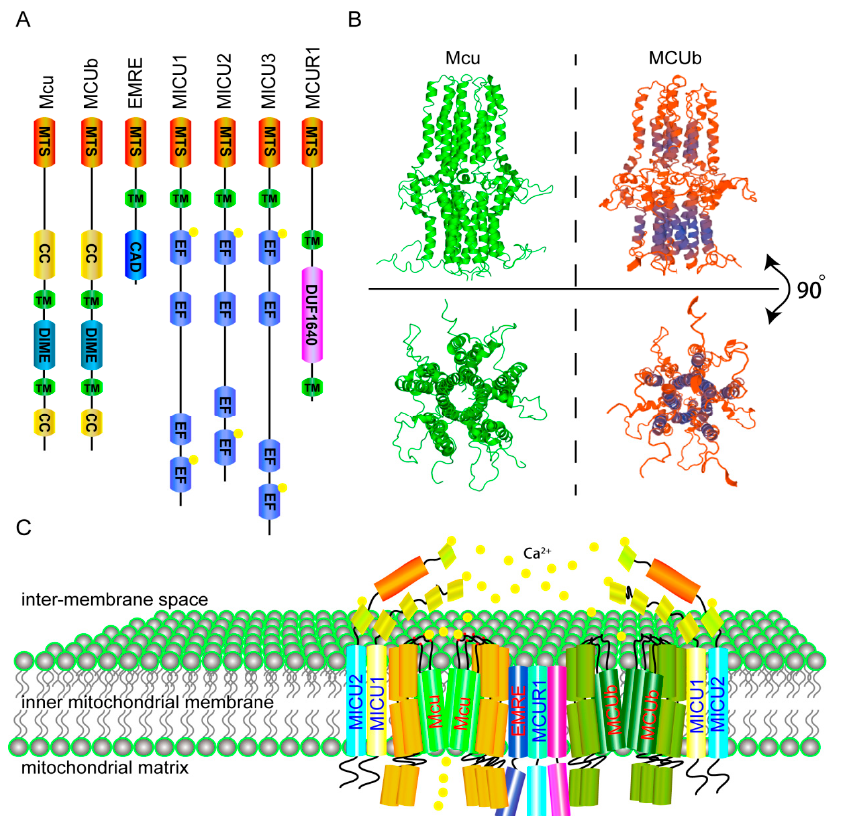
Figure 1. The molecular components and structure of mitochondrial calcium uniporter (MCU). ( A ) The components of Homo sapiens MCU. From left to right, the schematic shows a linear overview of the predicted domain architecture of each of the seven Homo sapiens MCU components. MTS: mitochondrial targeting signal, TM: transmembrane domain, CC: coiled-coil domain, DIME: the conserved DIME motif, CAD: carboxy-terminal domain, EF: EF-hand domain, DUF1640: protein of unknown function (DUF1640); ( B ) The structure of Mcu- ∆ NTD (left) and MCUb- ∆ NTD (right). Upper: front view of Mcu and MCUb show both of them have three distinct layers, down: top view displays the calcium pore formed by five transmembrane domains of Mcu (left) or MCUb (right) (http://swissmodel.expasy.org/repository/) [25,28]; ( C ) Cartoon of Homo sapiens MCU in the inner membrane of mitochondria.